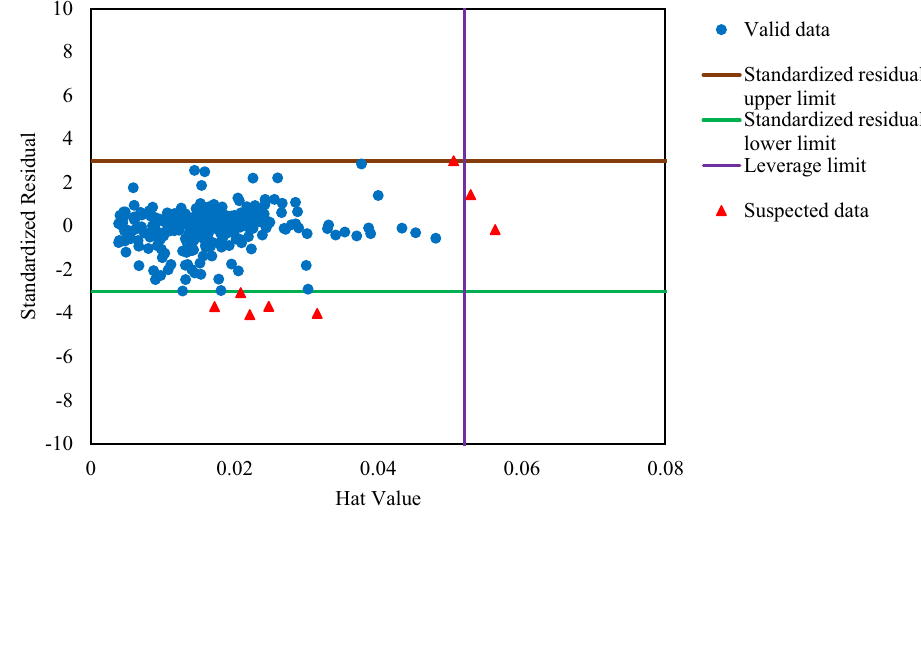
Fig. 9 The William’s plot of the developed GEP